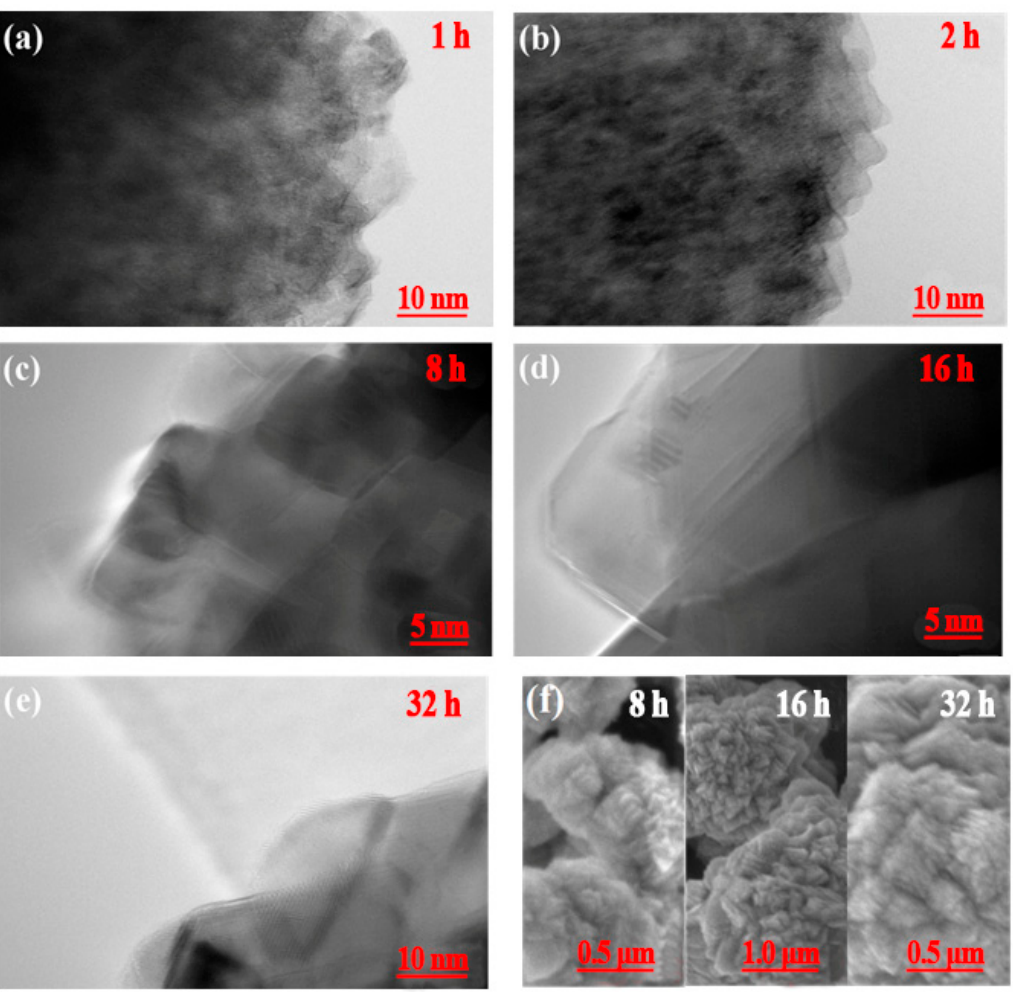
Figure 7. HR-TEM images ( a – e ) of the outer layers of CoCO 3 particles for different crystallization times. ( f ) Partial enlargement SEM image of the area marked in Figure 6 ( e , j , i ) with a red cycle.